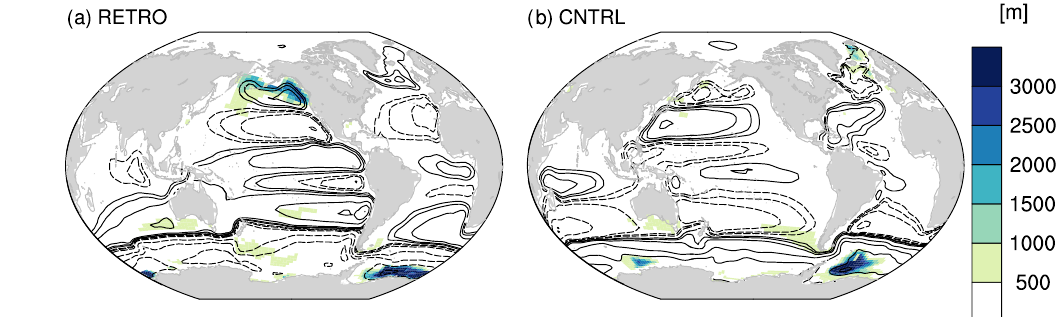
Figure 14. Maximum mixed layer depths and annual mean barotropic stream functions. Outlines are at ± 5, 10, 20, 60, 100Sv, and so on. (a) RETRO, (b)